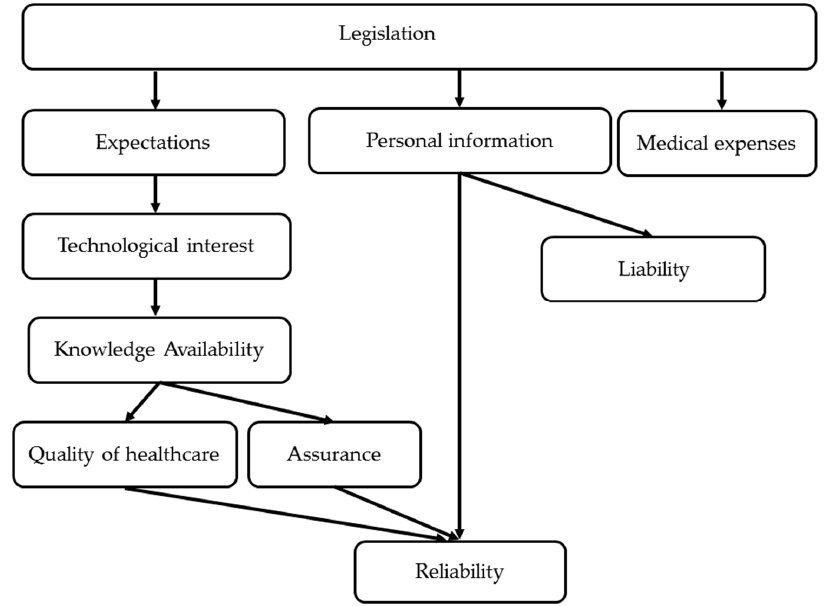
Figure 2. Interpretive structural modeling hierarchy diagram.